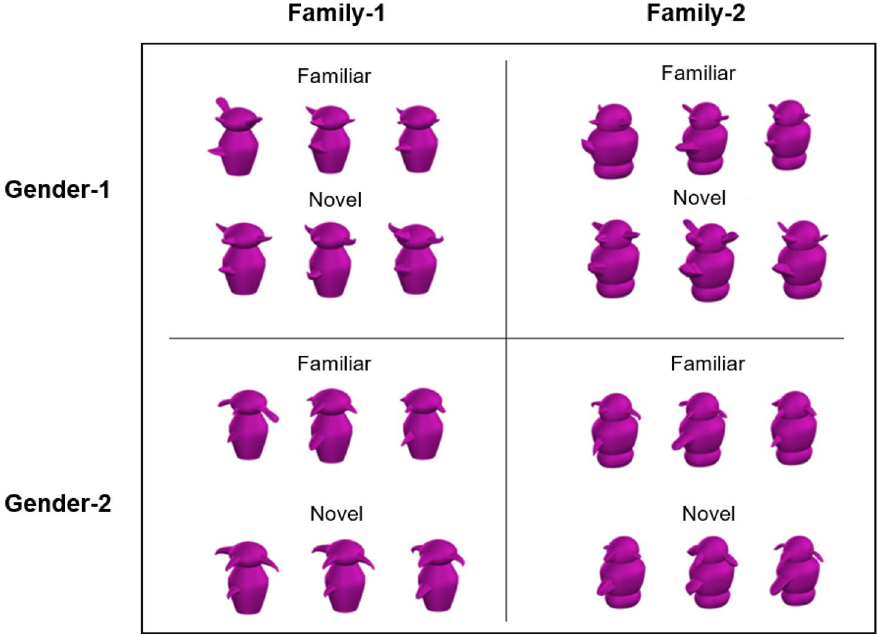
Figure 2. The 24 Greebles used in Experiments 3 and 5 included exemplars from two genders and two families. Stimulus images courtesy of Michael J. Tarr, Carnegie Mellon University, http:// www. tarrl ab.